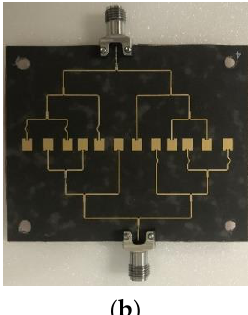
Figure 10. ( a ) Fabricated non-uniformly powered and uniformly spaced antenna array without parasitic patches. ( b ) Fabricated non-uniformly powered and spaced antenna array without parasitic patches.